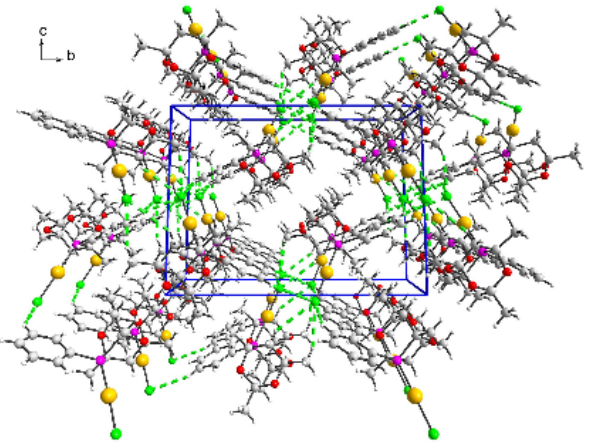
Figure 5. Perspective view of the packing along a axis for ( 3 ). C–H…Cl hydrogen bonds are marked by dotted green lines.